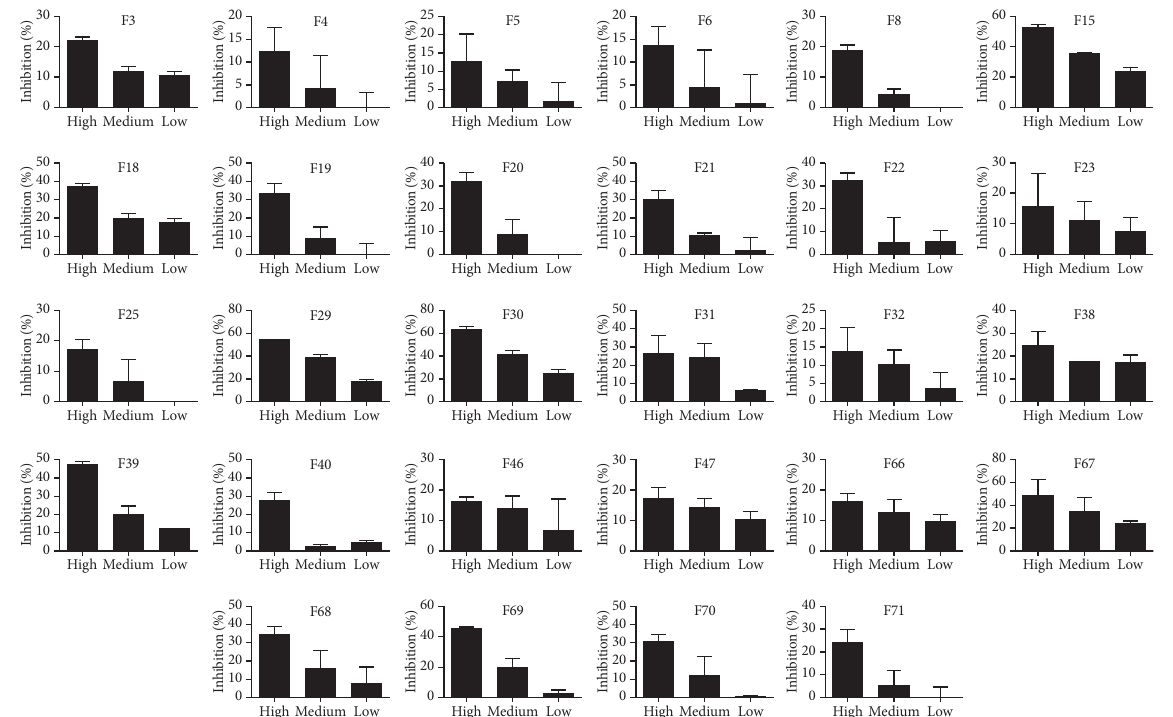
Figure 5: The 28 potential active fractions showed the NA inhibition with dose-effect relationships.